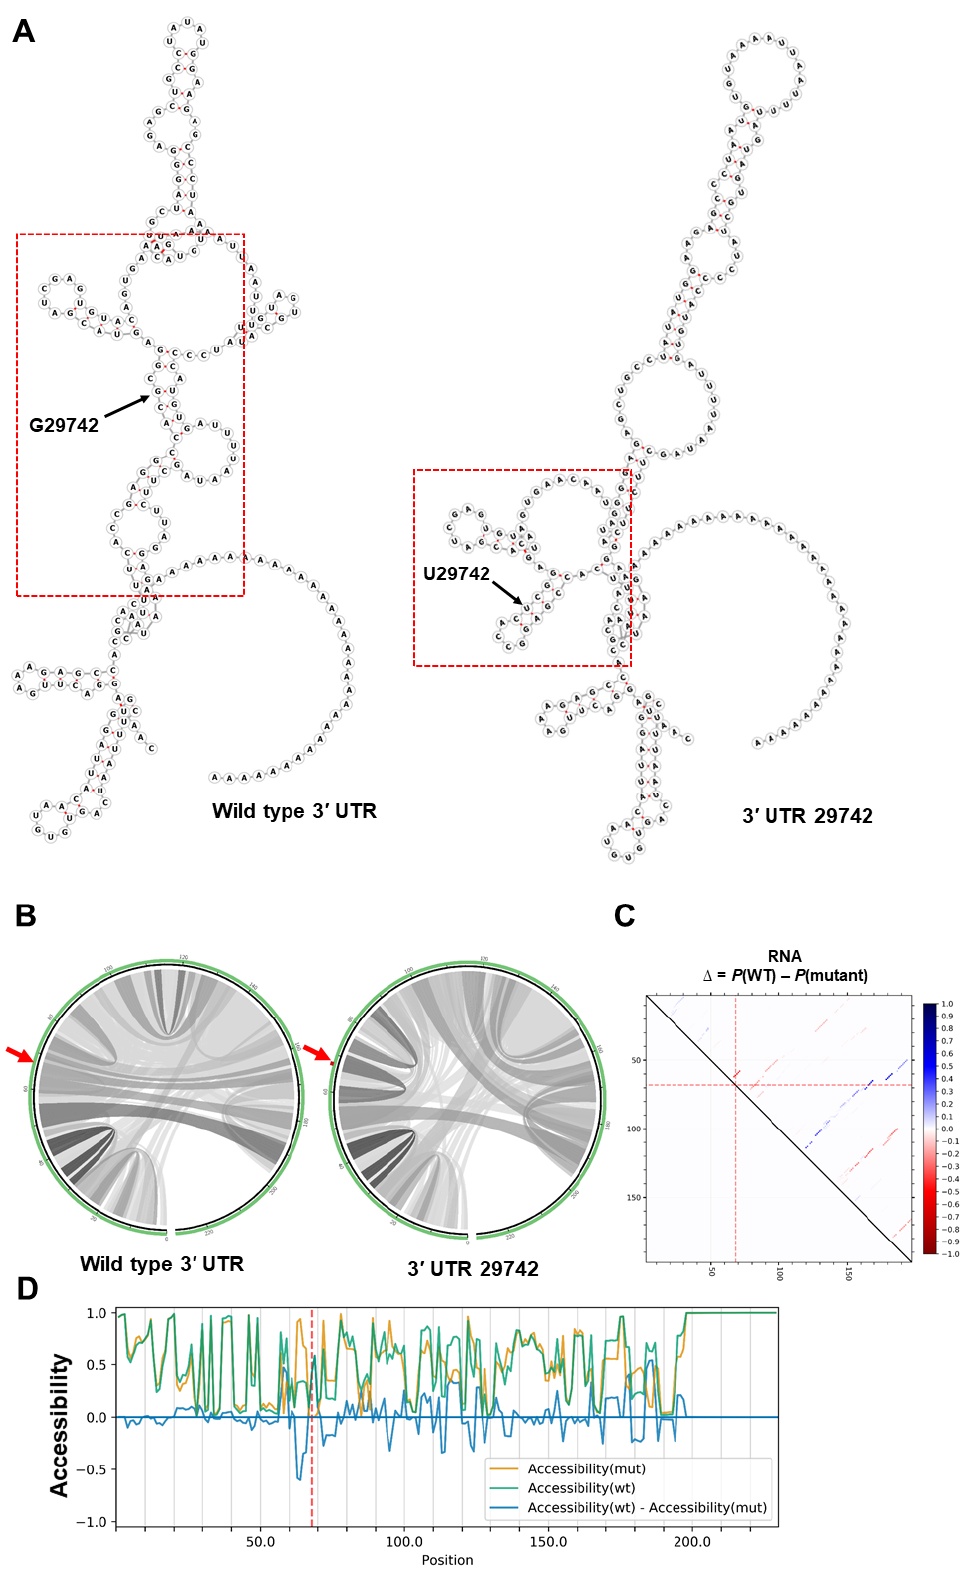
Figure 3. The impact of G29742U mutation on the 3 (cid:48) UTR. ( A ) The RNA secondary structures of wild type 3 (cid:48) UTR (MFE structure: − 36.90 kcal / mol—centroid structure: − 30.50 kcal / mol) and 29,742 mutation (MFE structure: − 40.30 kcal / mol—centroid structure: − 30.30 kcal / mol) using RNAfold tool. Note